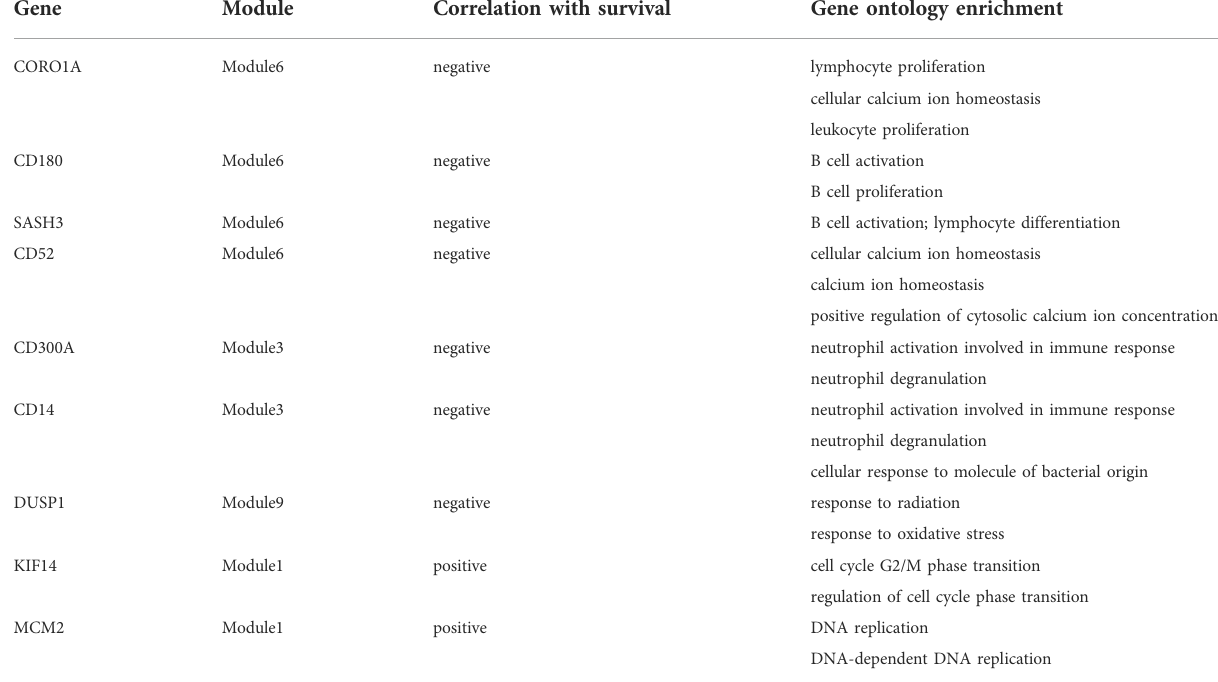
TABLE 2 The pro fi le of the genes that correlated with survival of ESCC patients.